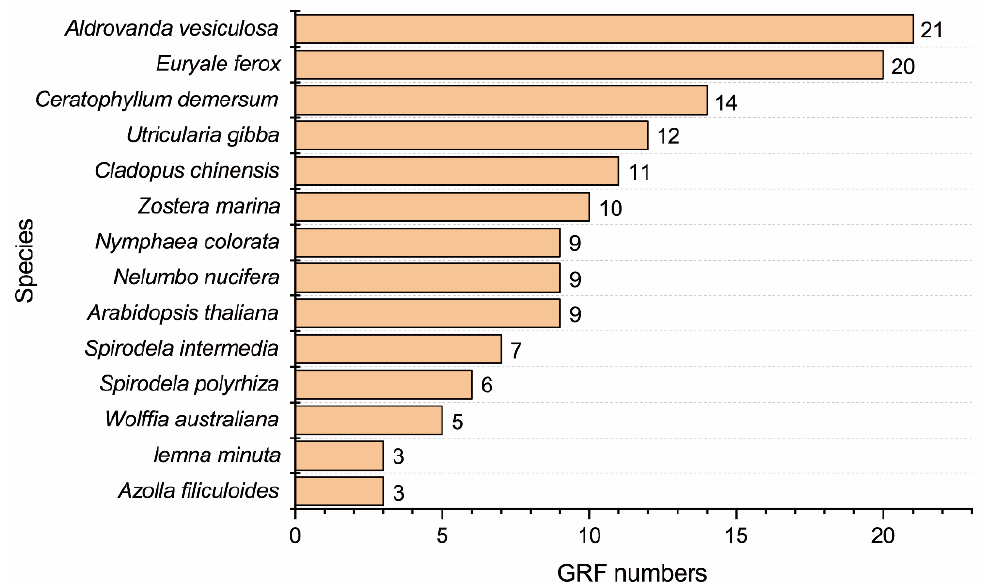
Figure 1. Calculations of the GRFs in A. thaliana and 13 aquatic plants.